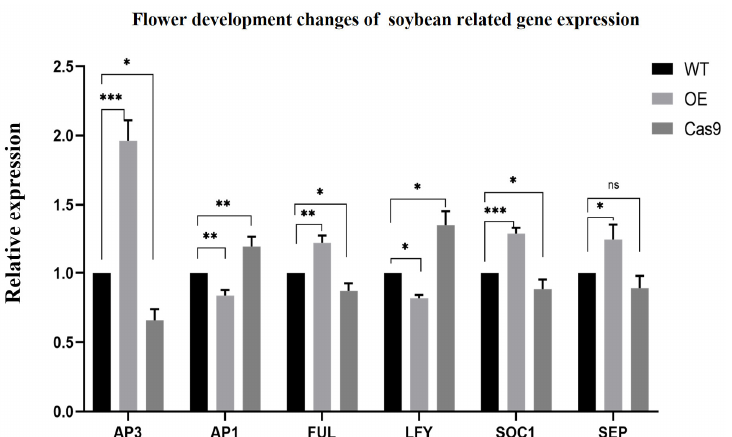
Figure 6. Expression analysis of key enzyme genes related to flower development in transgenic soybean. β -Actin was used as an internal control. Significant differences according to Student’s t -test are indicated. *, **, and *** indicate significant differences at p < 0.05, p < 0.01, and p < 0.001 levels, respectively. All data shown are means ± SD of three biological replicates.